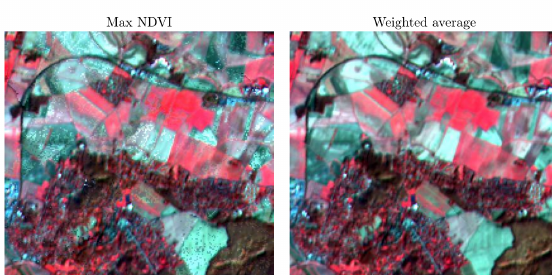
Figure 1. comparison of a monthly synthesis obtained using a best available pixel method (left) and a using a weighted average method (right). The higher level of noise on the best available pixel image is due to the selection of different dates on adjacent pixels